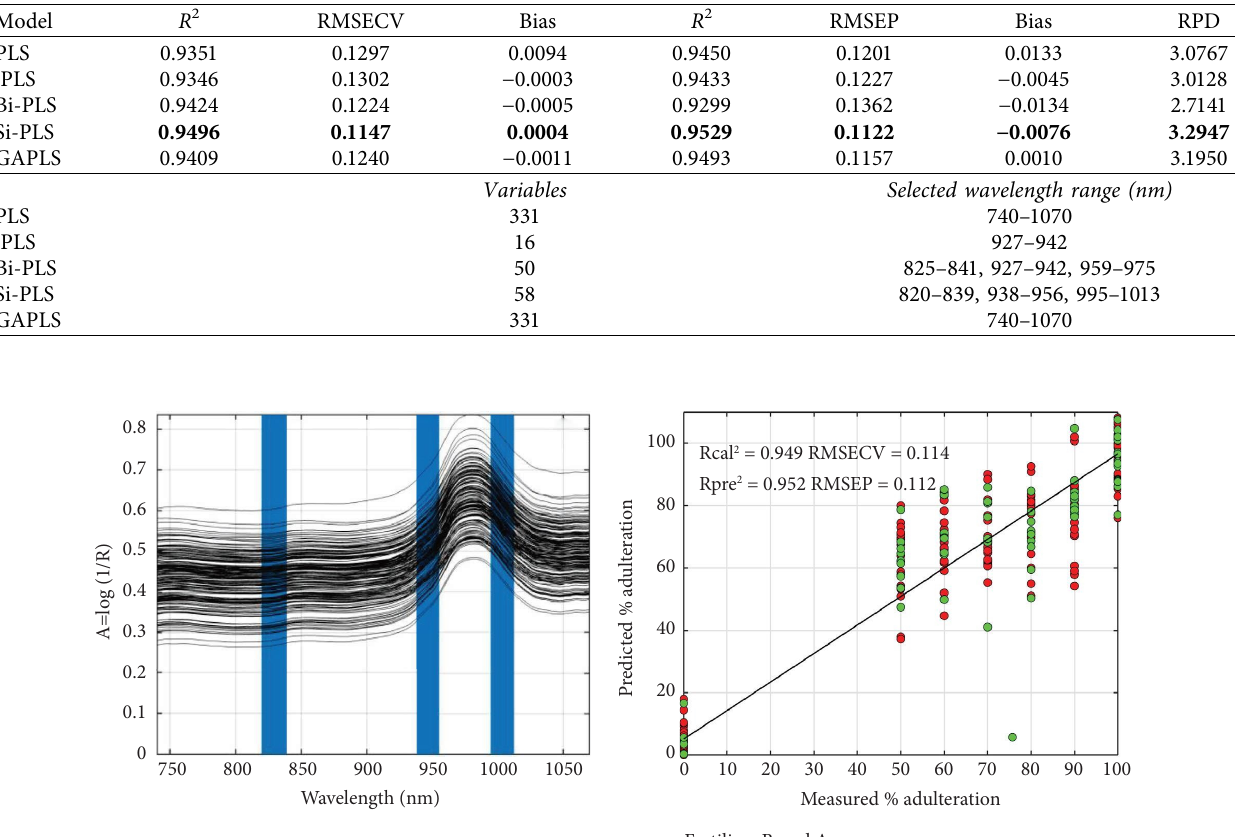
Table 4: Optimum performance of diferent quantifcation models for fertilizer